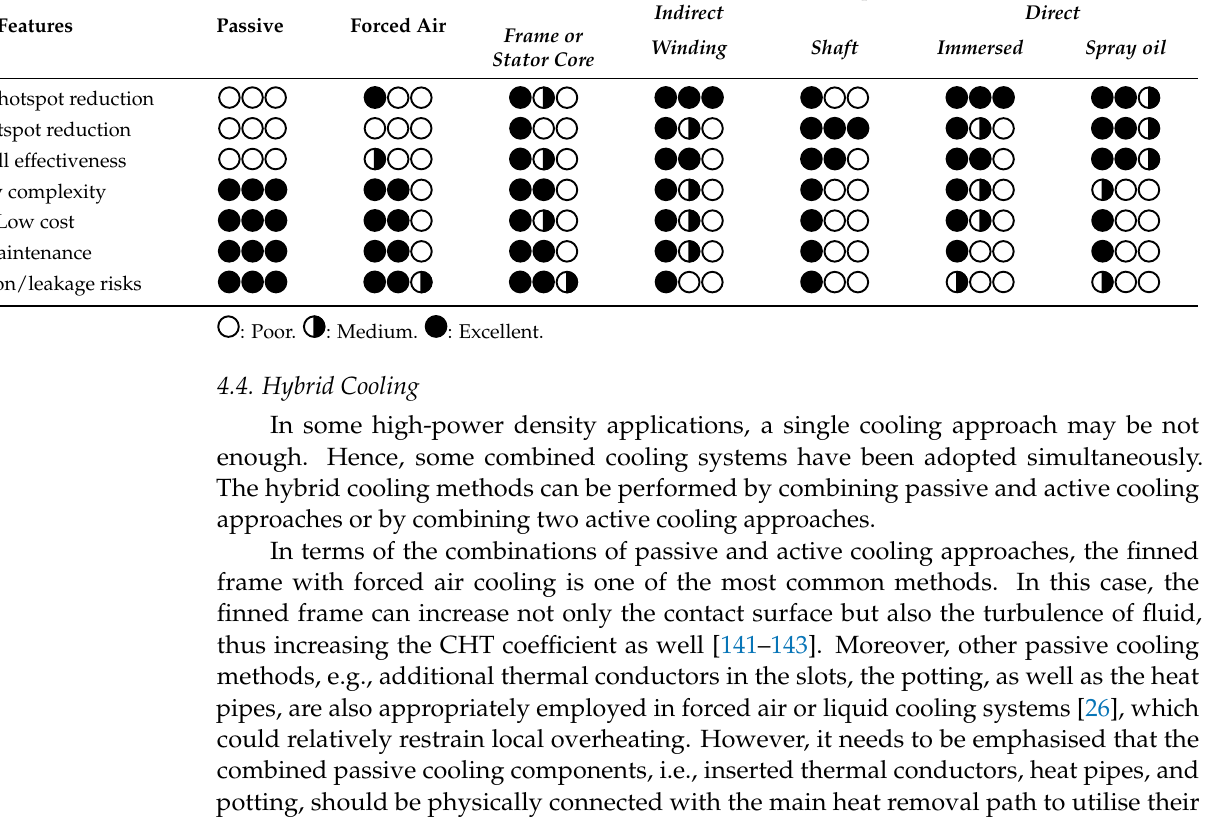
Table 4. Evaluation of common cooling techniques for electrical machines.